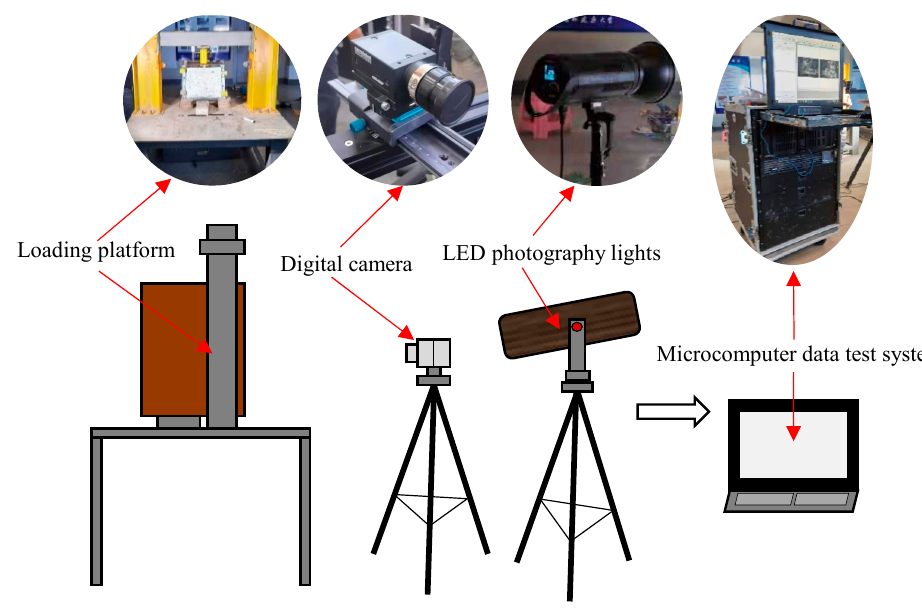
Figure 7. Loading and VIC-3D test system.